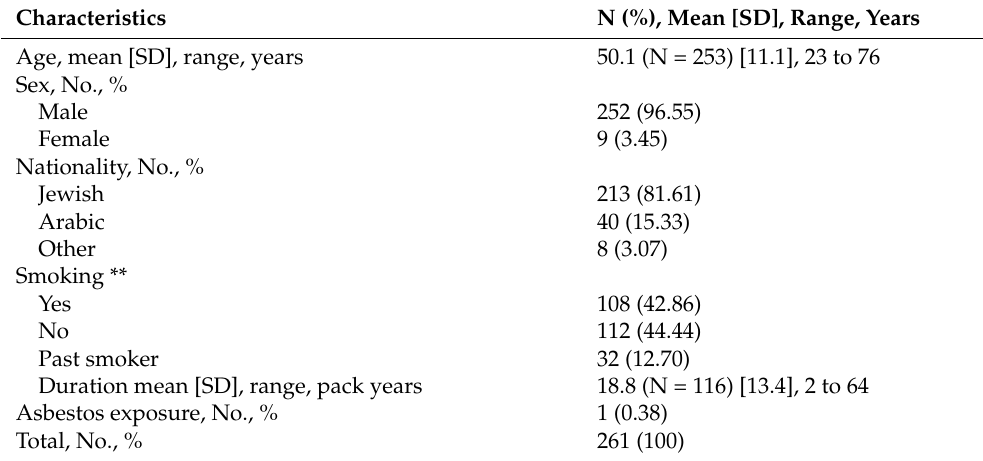
Table 1. Participants’ demographic and clinical characteristics *.